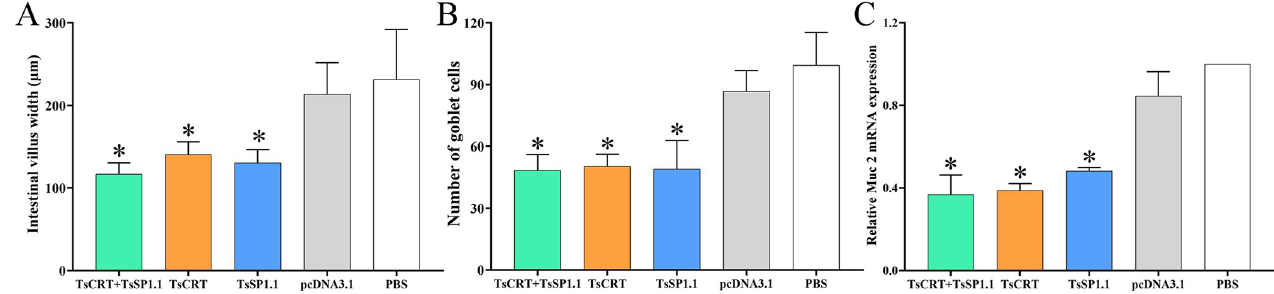
Fig 14. Intestinal pathological changes in immunized mice at 7 days after T . spiralis challenge. A: Intestinal villus width. B: Number of intestinal goblet cells. C: Relative expression level of mucin 2 mRNA. � P < 0.001 compared to the PBS groups.